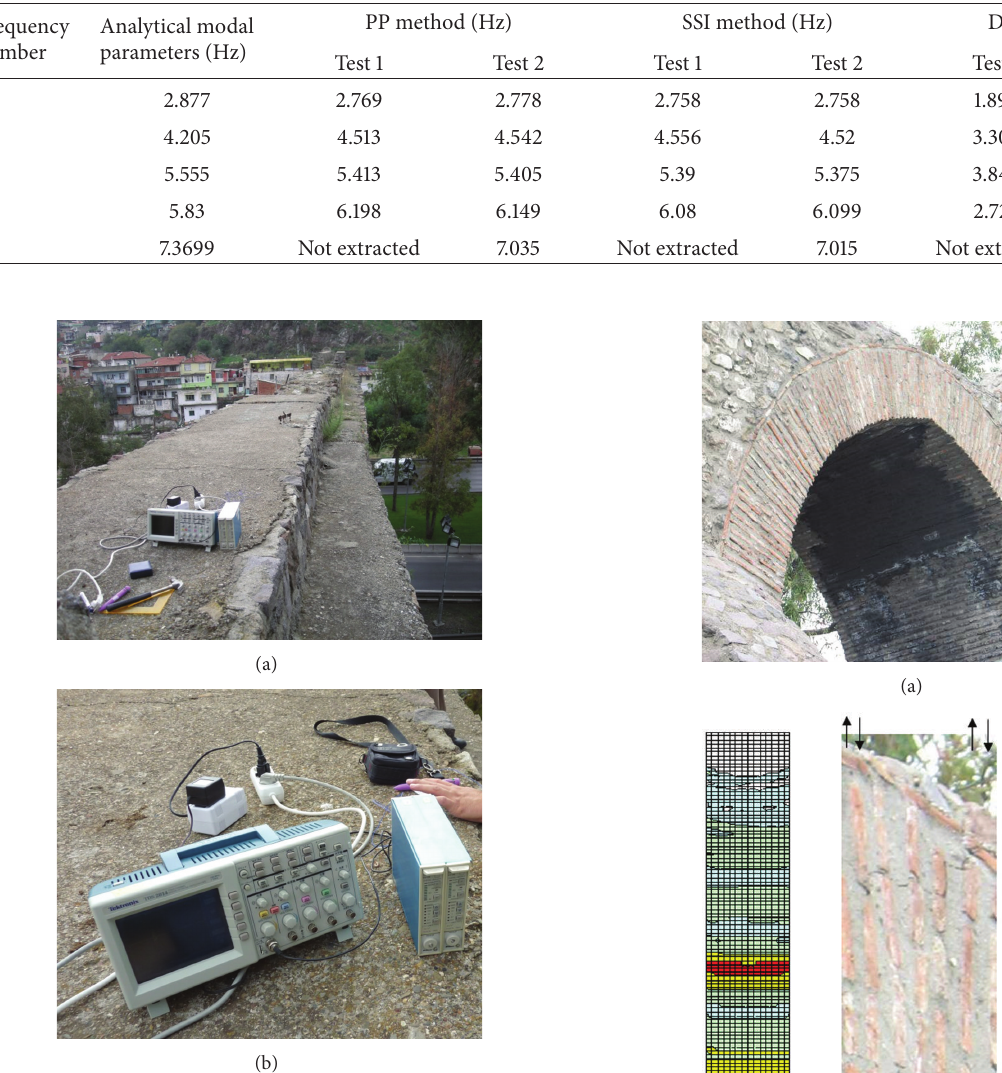
Table 3: Comparison of analytical and experimental modal parameters.